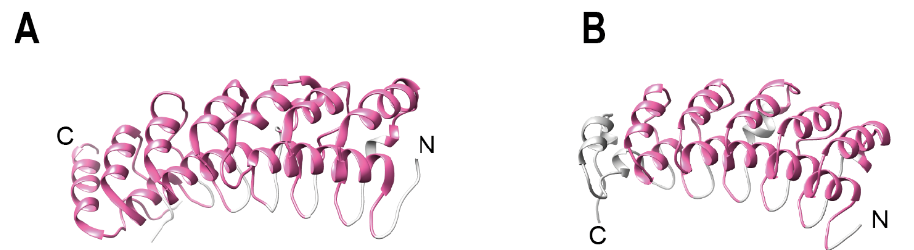
Figure 1. Examples of naturally occurring ankyrin repeat containing proteins. ( A ) Ankyrin repeat containing protein p100/NF- κ B2 (Q00653). Structure of the C-terminal domain (PDB 4OT9, residues 483-756). The ankyrin repeats are colored in pink. ( B ) Ankyrin repeat containing protein I κ B α (P25963). Structure of I κ B α in complex with NF- κ B (PDB 1NFI, residues 70-282). The ankyrin repeats domains are colored in pink.